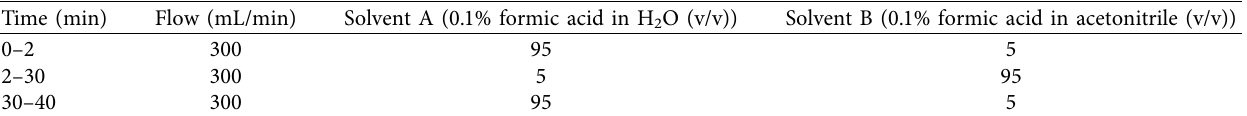
Table 3: Gradient flow profiles of the mobile